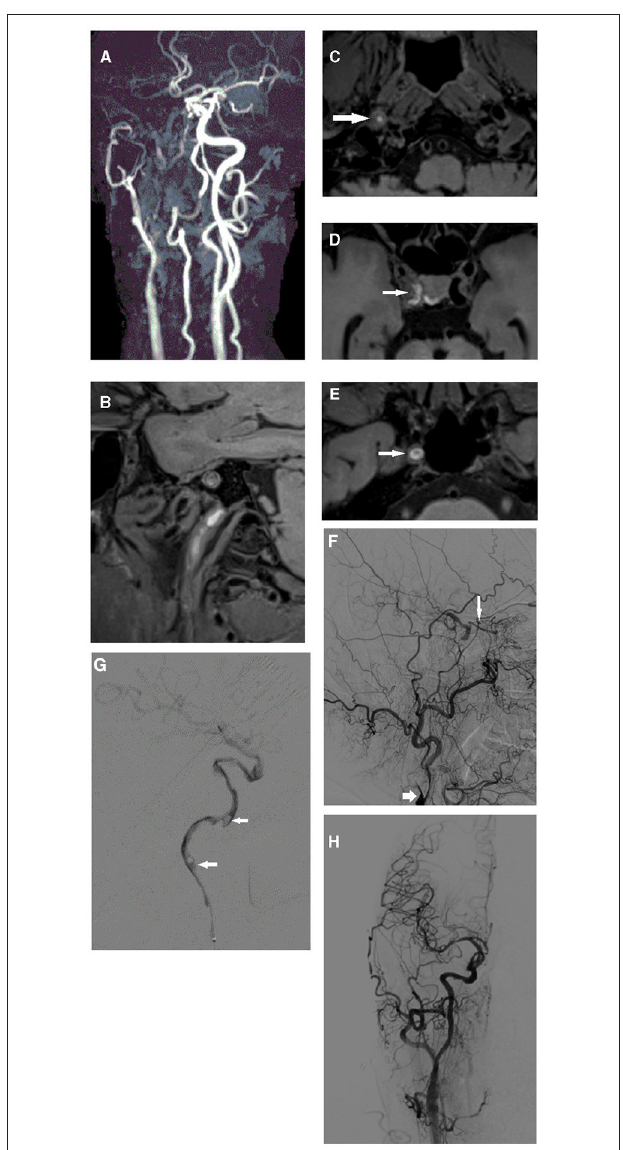
FIGURE 3 | Second illustrative case of right internal carotid occlusion with recurrent ischemic events: (A) Long segmental occlusion of right internal carotid artery was detected by TOF MRA. (B–D) Intraluminal high signals were detected from cervical segment to clinic segment (white arrow) on 3D SPACE sequence. (E) After contrast injection intravenously, enhanced patent wall was delineated (white arrow). (F) Lateral images on DSA exhibited the tapered stump (short white arrow) and reversed ophthalmic artery (long white arrow). (G) Microcatheter angiograph exhibited long segmental filling defect sign (white arrow). (H) After aspiration with Sofia catheter (Microvention, Terumo, Japan), we retrieved a long old thrombus and restored the normal blood